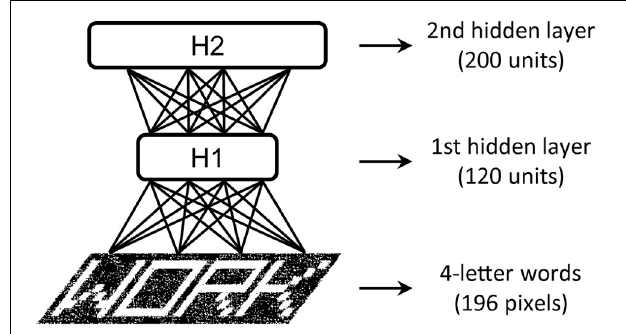
FIGURE 4 | Architecture of the DBN with two hidden layers used in the written word perception